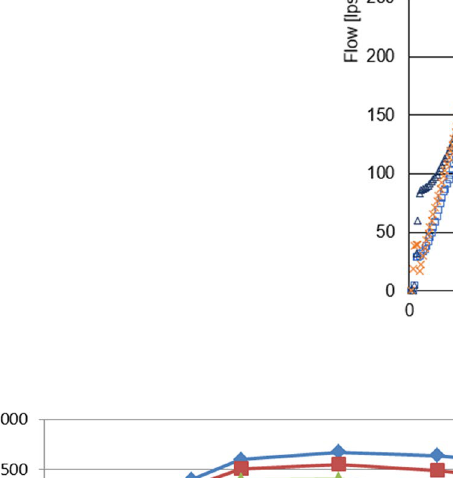
Fig. 5 Outflow from the tank in time calculated for the data identical as for Fig. 4 despite the duration of storm equals this time to 5∙ t dd , where t dd is the time of the flow through sew‑ ers of the total length from its start to the design cross section above the tank